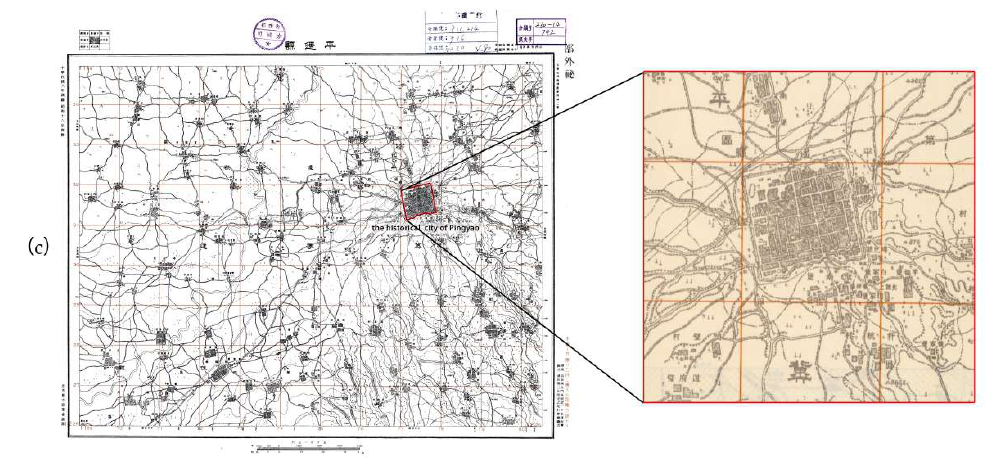
Figure 5. Land survey maps of Pingyao in 1919 ( a ), 1933 ( b ), 1941 ( c ). (Maps retrieved from Ministry of the Interior, Administrative Department of Taiwan, China).